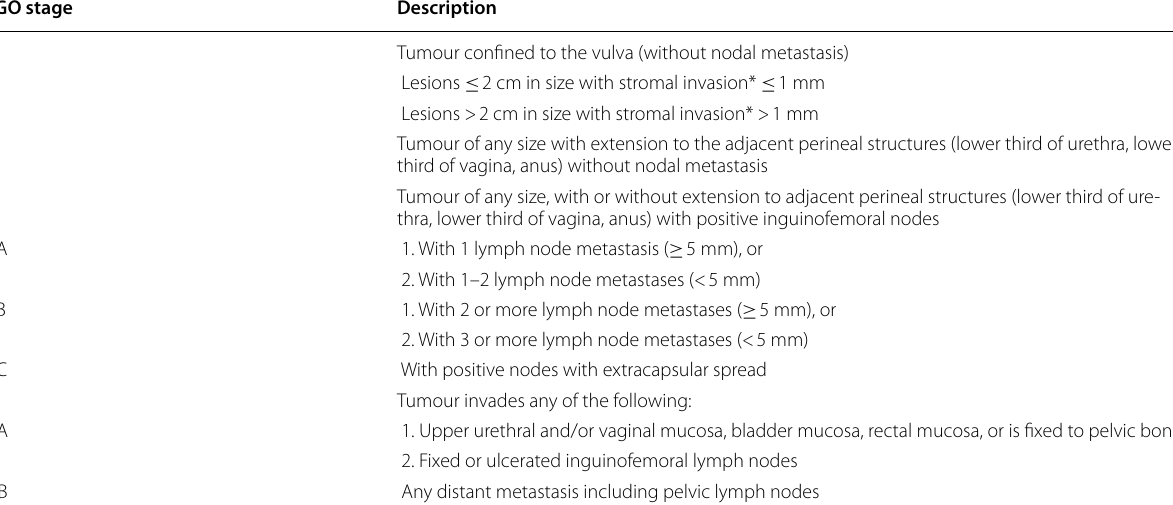
* The depth of invasion is defined as the measurement of the tumour from the epithelial-stromal junction of the adjacent most superficial dermal papilla to the deepest point of invasion